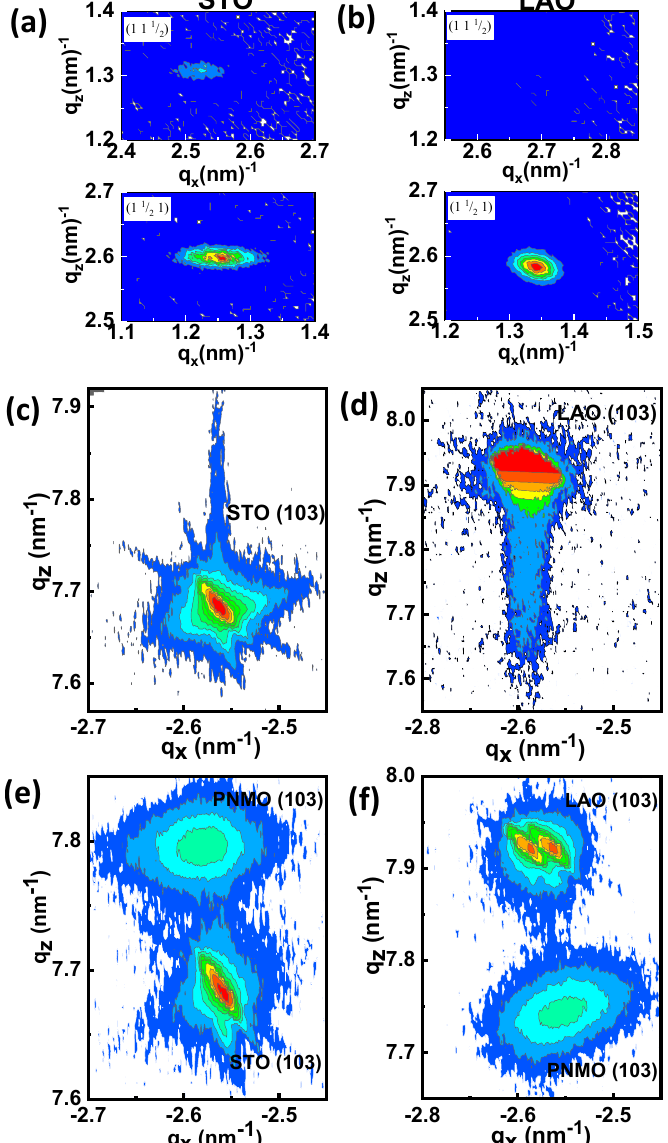
Figure 2. Integration along q y of the intensity diffracted in the vicinity of the positions corresponding to (11 ½) and (1 ½ 1) for ( a ) the t = 47.6 nm PNMO/STO (001) film and ( b ) the t = 43.4 nm PNMO/LAO (001) film. Reciprocal Space Maps (RSMs) around ( − 103) reflections of PNMO films grown on STO with ( c ) t = 5.2 nm and ( e ) t = 47.6 nm and grown on LAO with ( d ) t = 4.7 nm and ( f ) t = 43.4 nm.